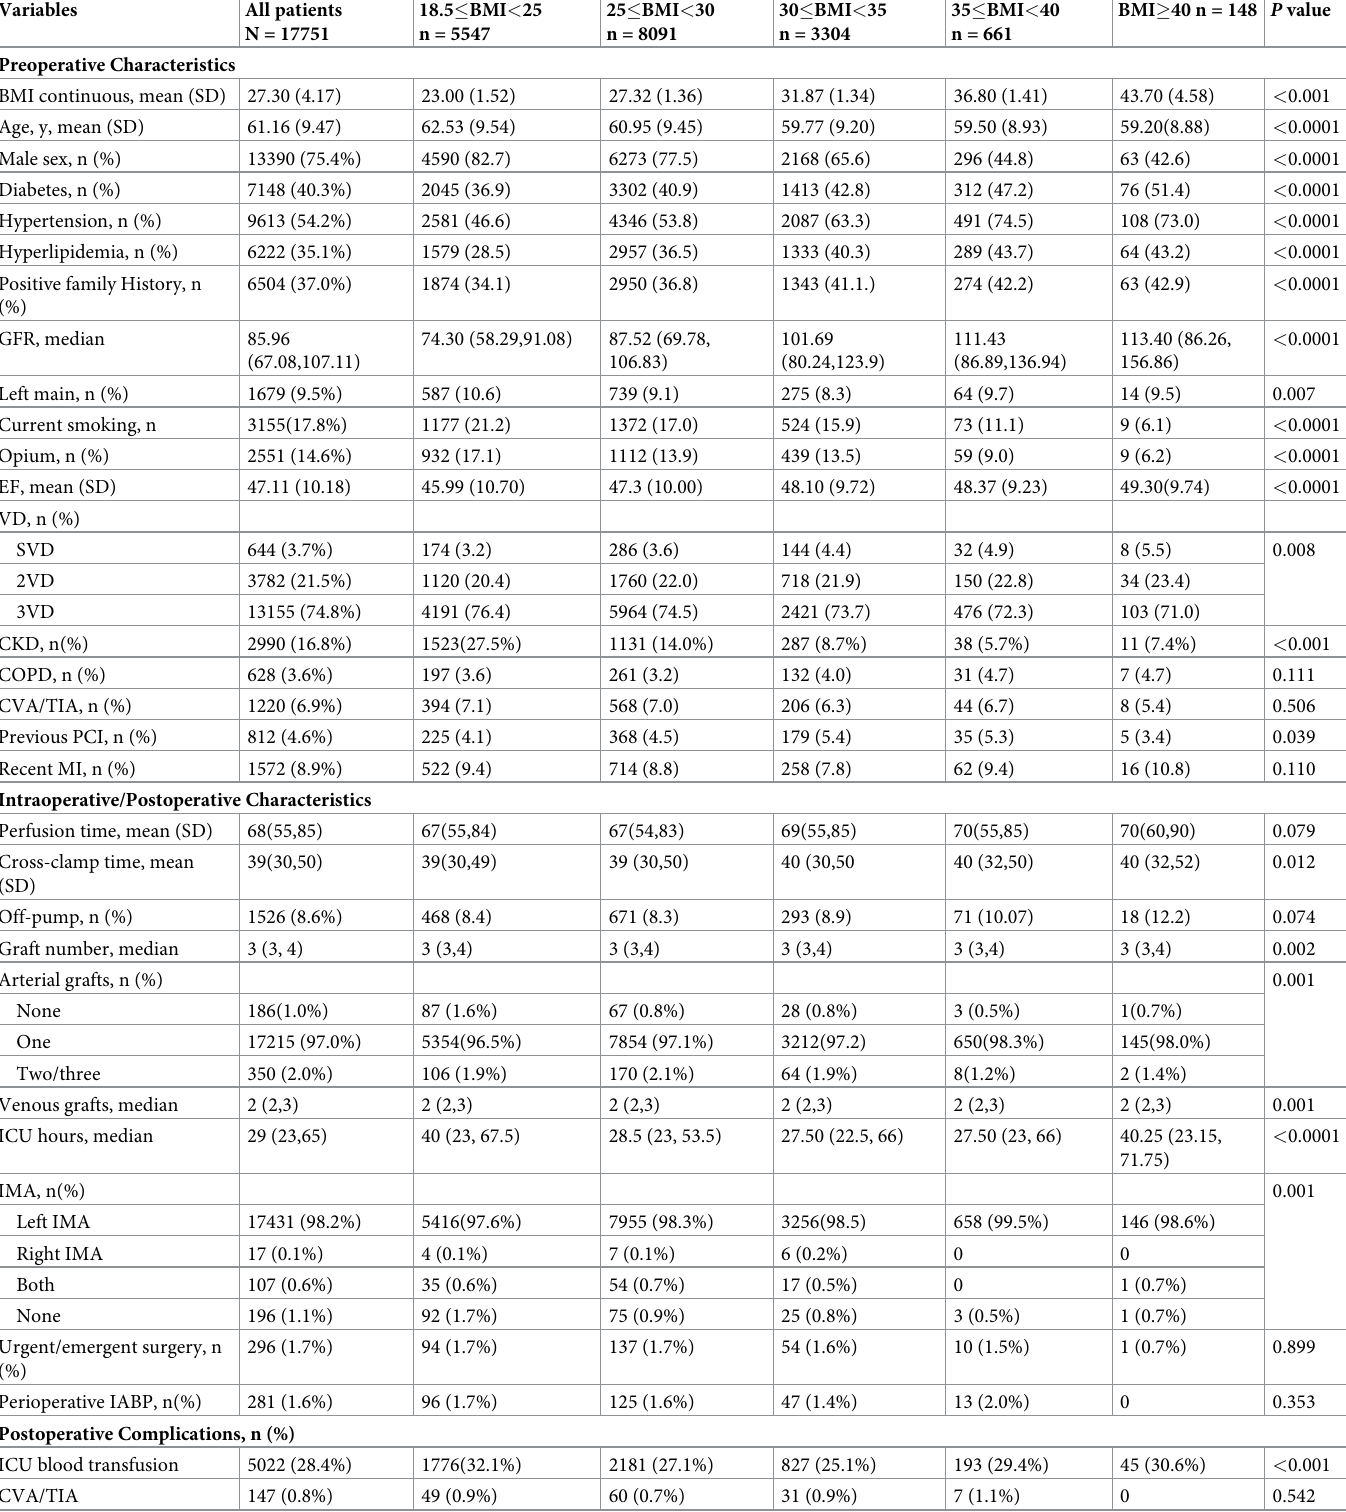
Table 1. Baseline characteristics of the study population based on